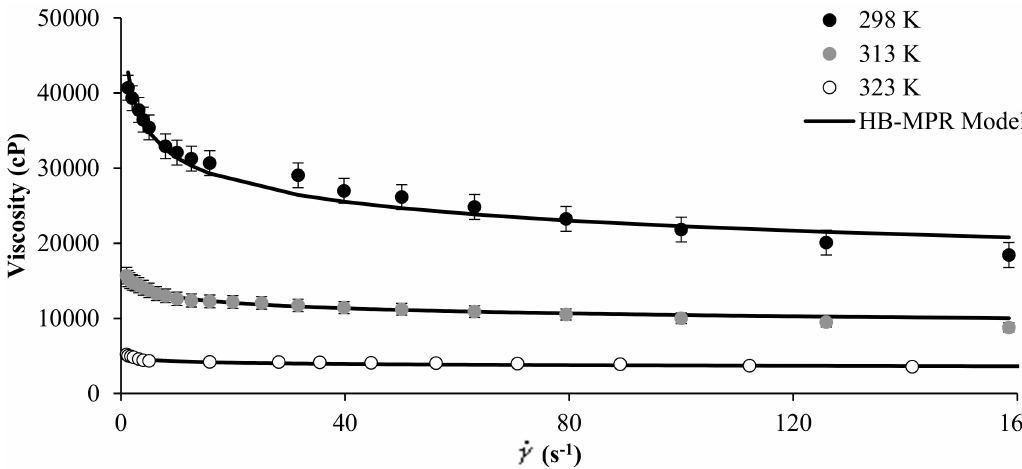
Figure 2. Viscosity of MB heavy oil in the presence of 1000 mg/L of SiO 2 nanoparticles at different temperatures and shear rate between 0 and 160 s − 1